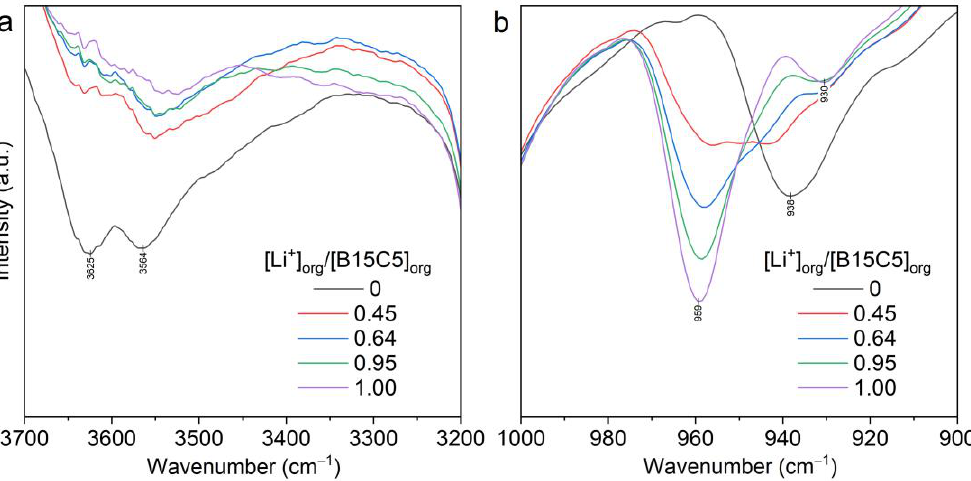
Figure 15. FTIR spectra of LiCl-B15C5 (0.5 mol/L)-[C8mim][NTf 2 ] extracts at different [Li + ]/[B15C5]